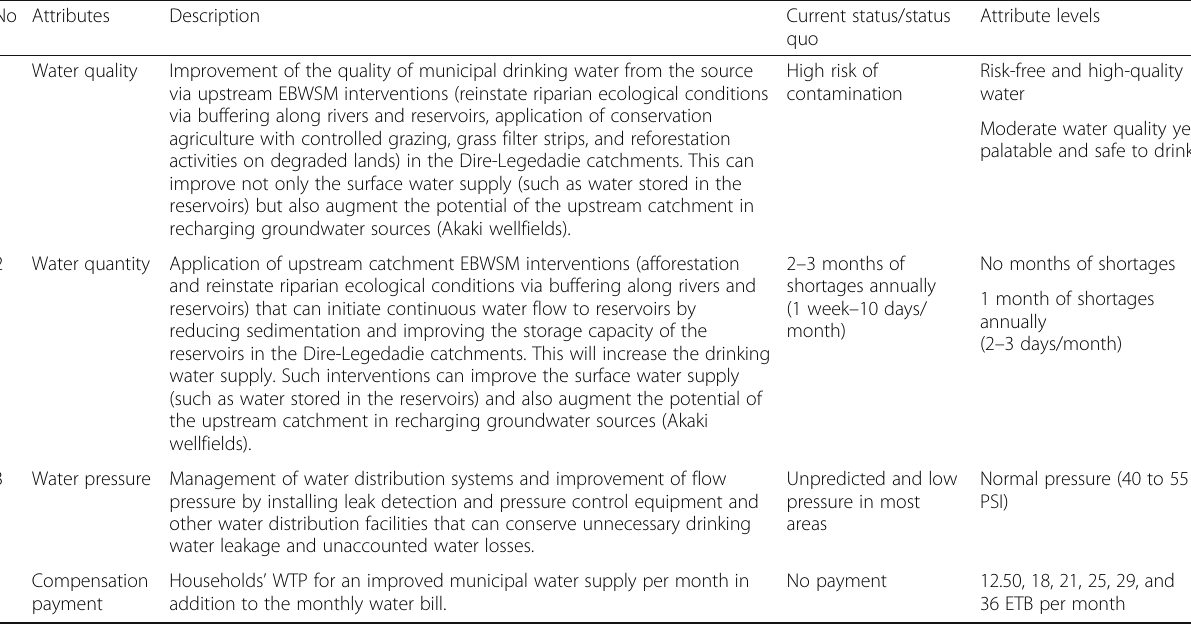
Table 1 Attributes and levels used in the DCEs to improve